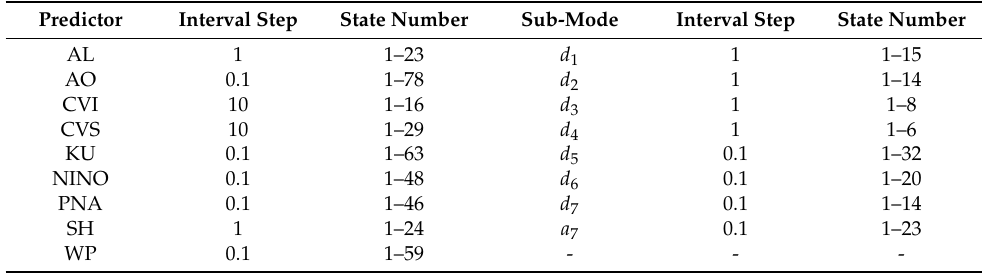
Table 2. Discretization standard for predictors and modes of STII.